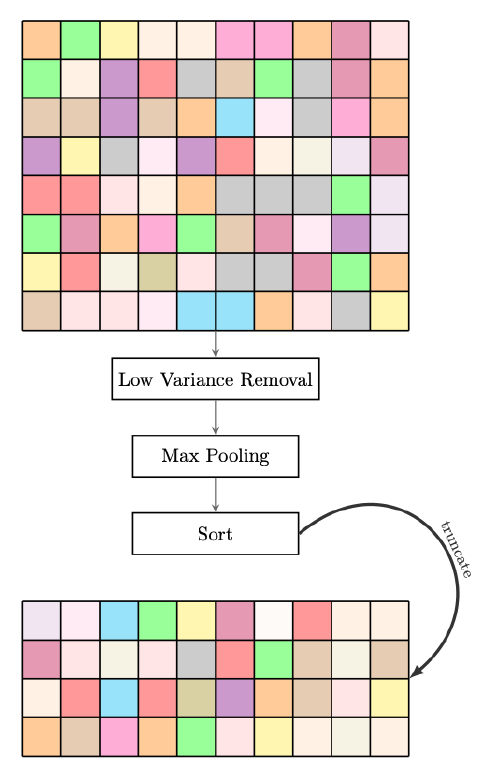
Figure 6. This figure shows a diagram of the variance-based feature selection. After the Eigen features are calculated, using a combination of local eigenvalues and MLPs, we obtain a feature descriptor for each point in the point cloud. We remove any point with low variance in the descriptor from consideration and then perform a max-pooling operation. The selected features are those with the highest feature response.